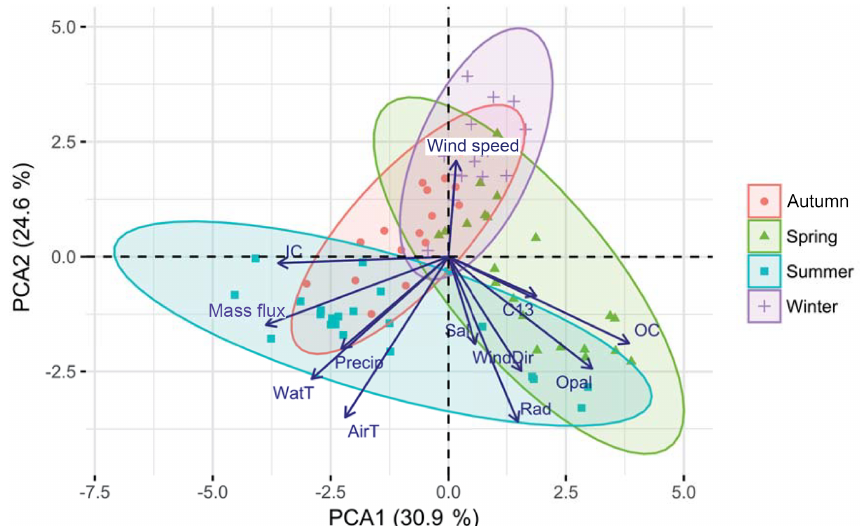
Figure 4. Principal component analysis (PCA) of the collected data set arranged by seasons. The abbreviations are as follows: total mass flux (Mass Flux), organic carbon (OC), δ 13 C (C13), inorganic carbon (IC), opal (Opal), air temperature (AirT), wind speed and direction (WindSpeed, WindDir), solar radiation (Rad), rain precipitation (Precip), salinity (Sal), and water temperature